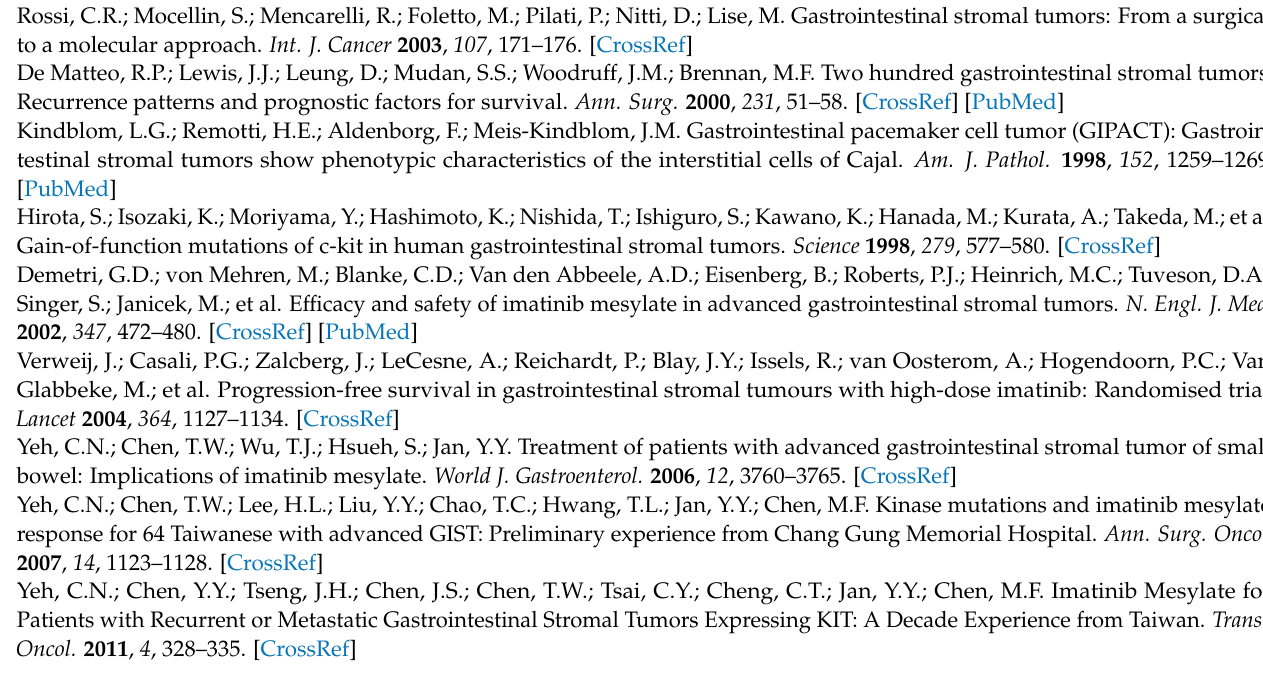
Table S3: Hazard ratios of predictor variables in multivariate